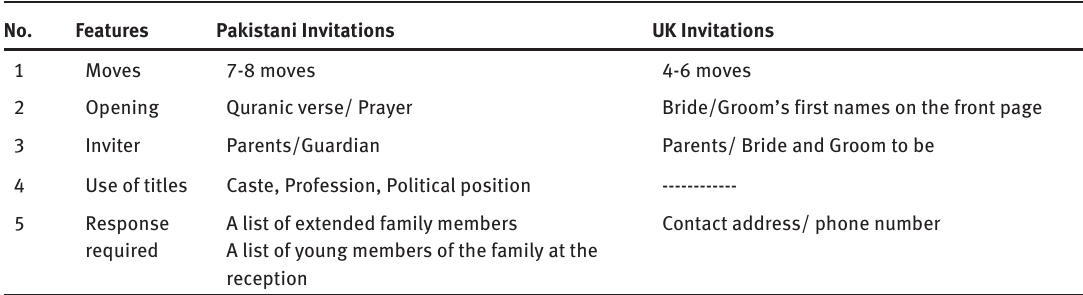
Table 3: A comparison of wedding invitations of Pakistan and UK No.